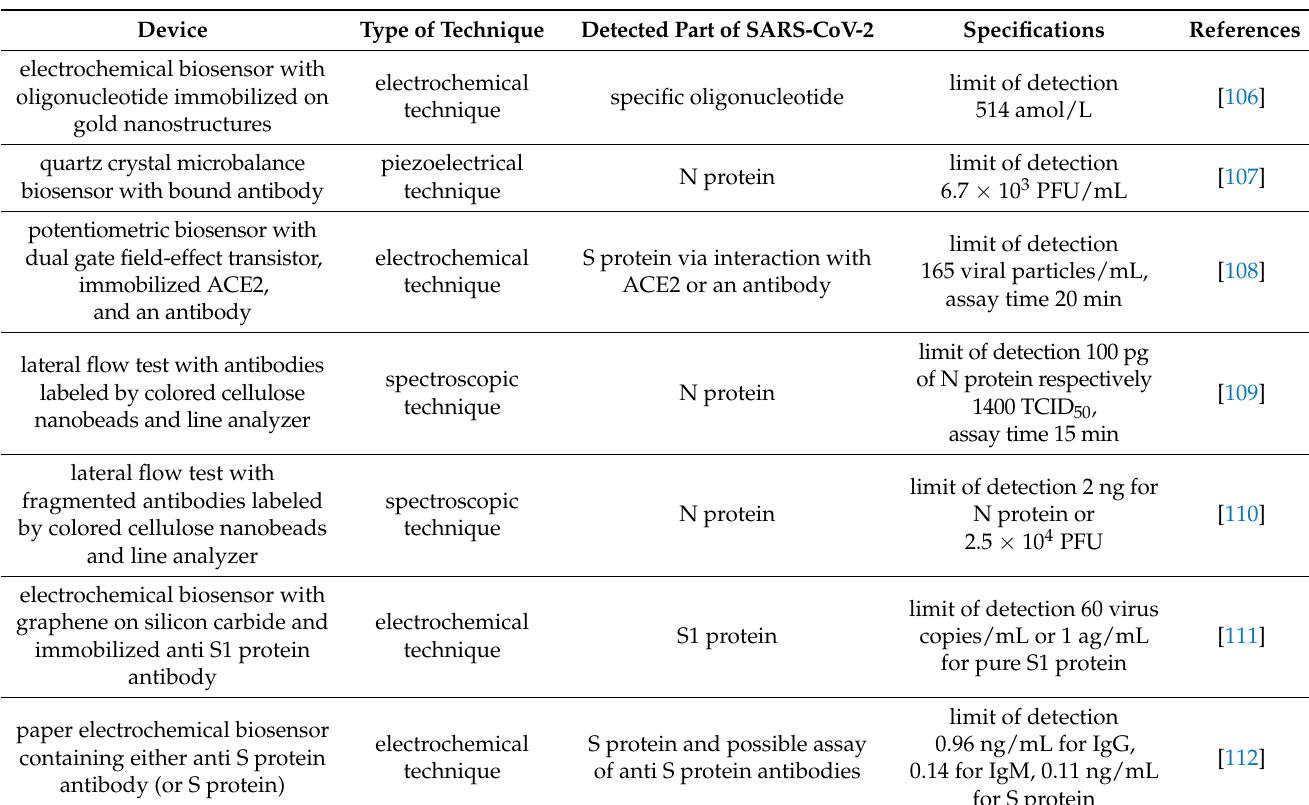
Table 2. Point-of-care biosensors for SARS-CoV-2